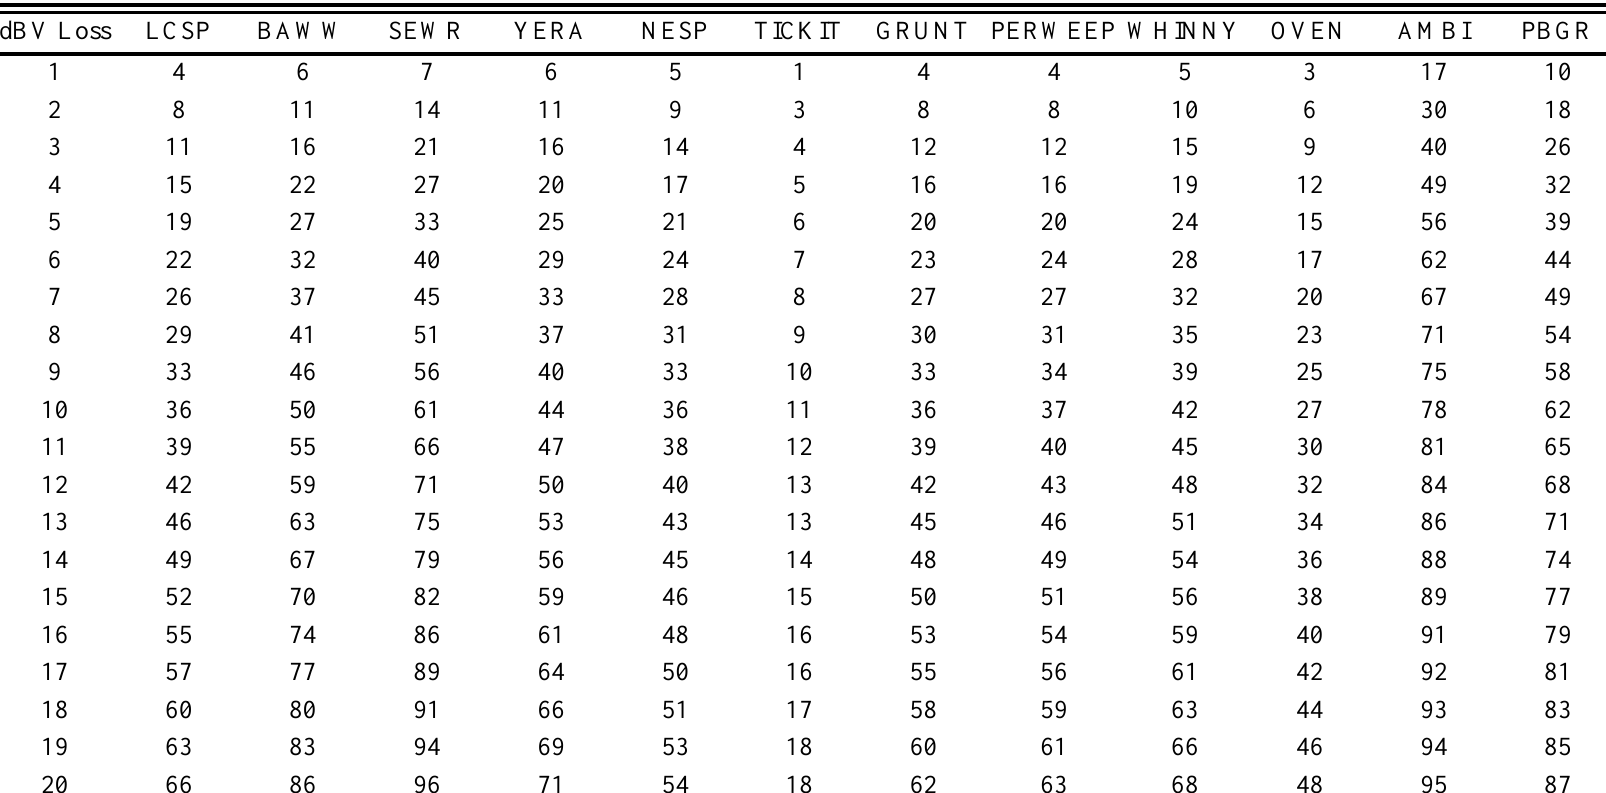
Table A5.5. Percent effective detection area loss of 12 call types for varying degrees of microphone sensitivity loss under 42 dBA noise